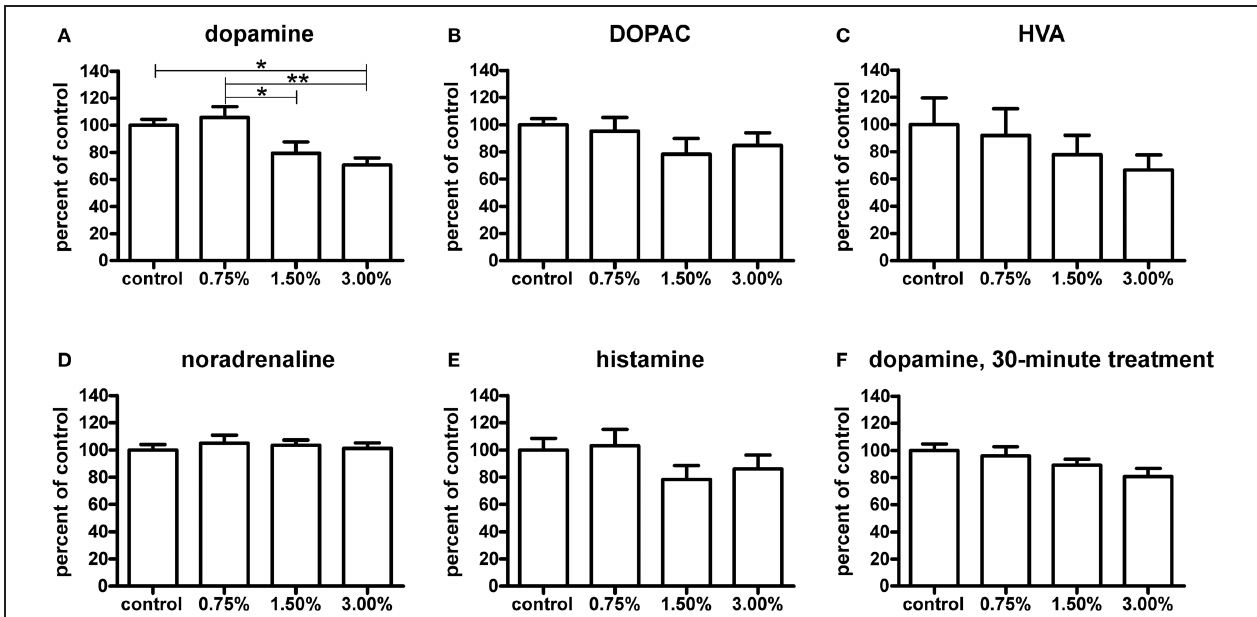
F ( 3 , 24 ) = 0 . 2692, p = 0 . 8470; histamine: F ( 3 , 24 ) = 1 . 246, p = 0 . 3149], but a slight decrease trend of the histamine levels can be seen in the 1.50%